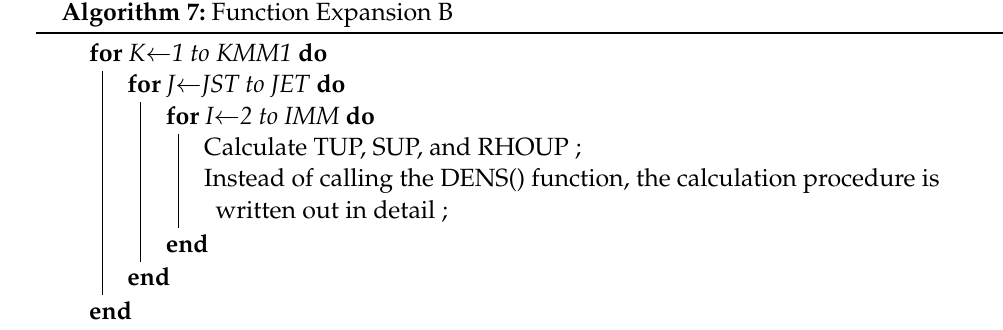
Algorithm 7: Function Expansion B